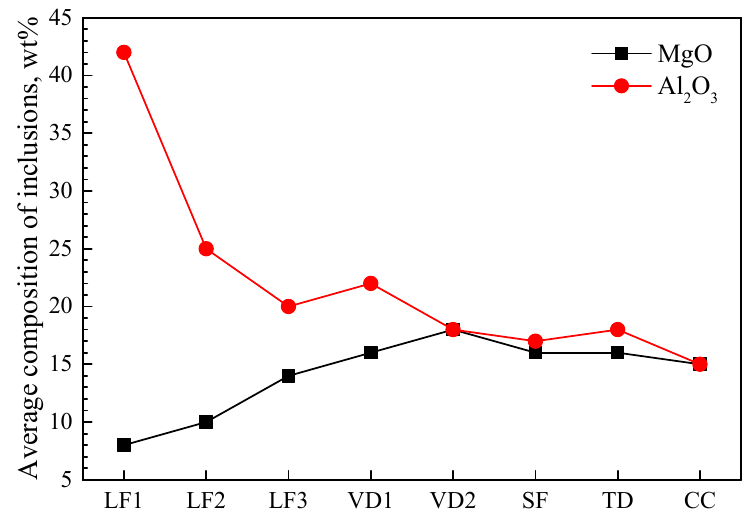
Figure 2. Morphology and composition of typical inclusions in steel.